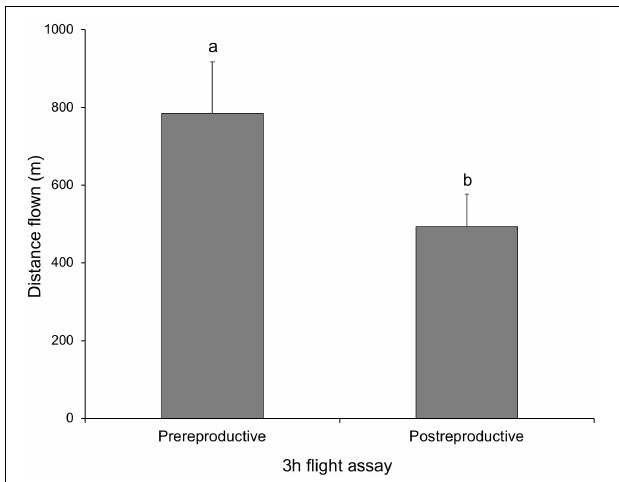
FIGURE 4 | Mean (+ SE) distances flown by Hippodamia convergens females (all treatments pooled) during 3 h bouts of tethered flight prior to oviposition (Prereproductive), and after 18 days of oviposition (Postreproductive). Values were significantly different (paired t -test, P < 0.001).